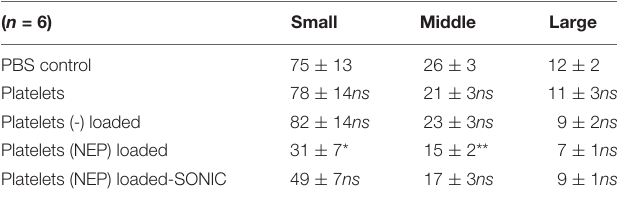
TABLE 2 | Quantification of beta-amyloid plaques in brain slices treated with neprilysin loaded platelets.